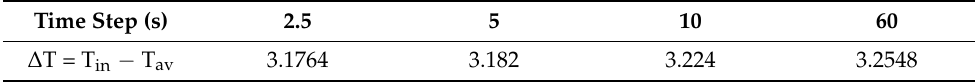
Table 4. Time step analysis for Case 3, u in = 3 m/s, and T in = 45 ◦ C. Time Step